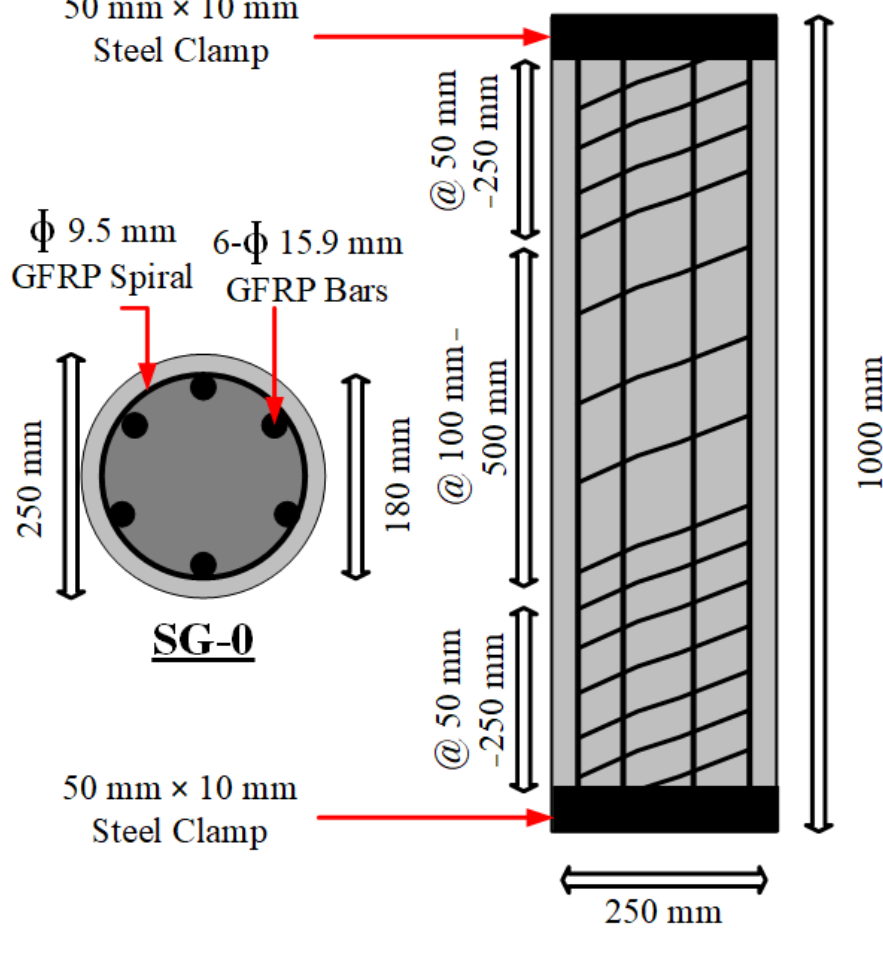
Figure 3. Detailing of